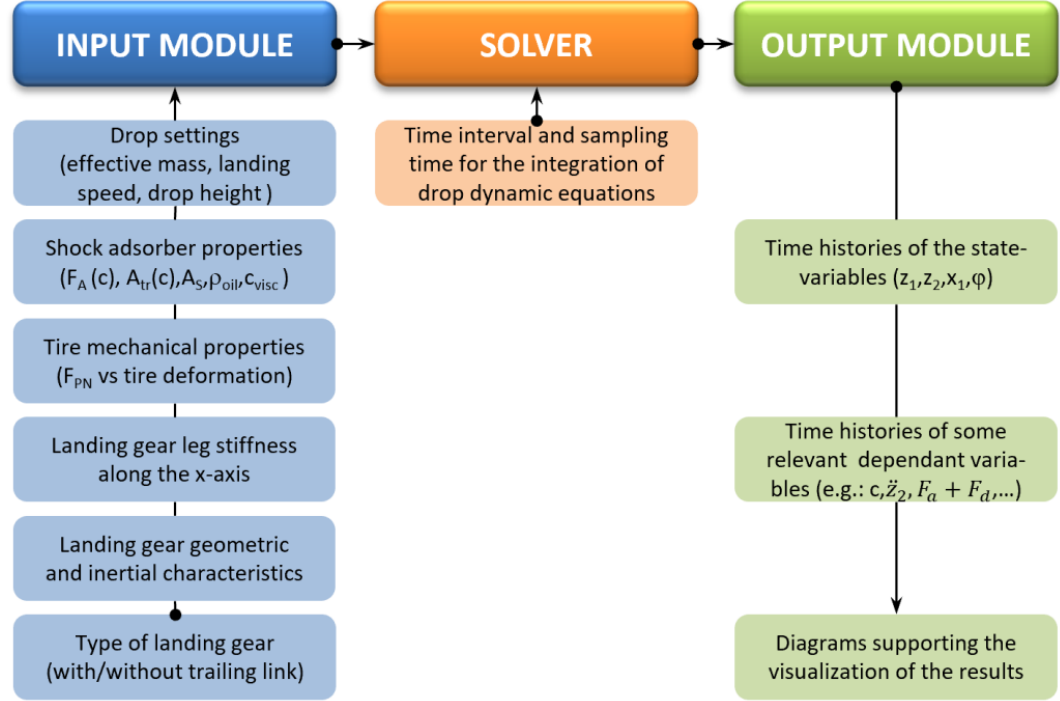
Figure 5. Main modules and structure of drop test simulation tool.